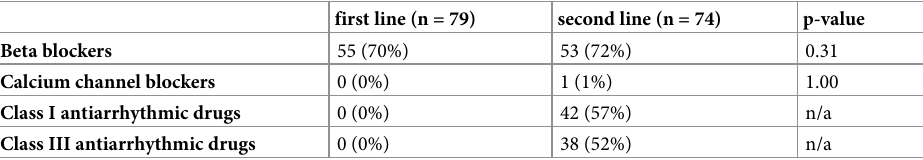
Table 2. Antiarrhythmic drug therapy prior to AF